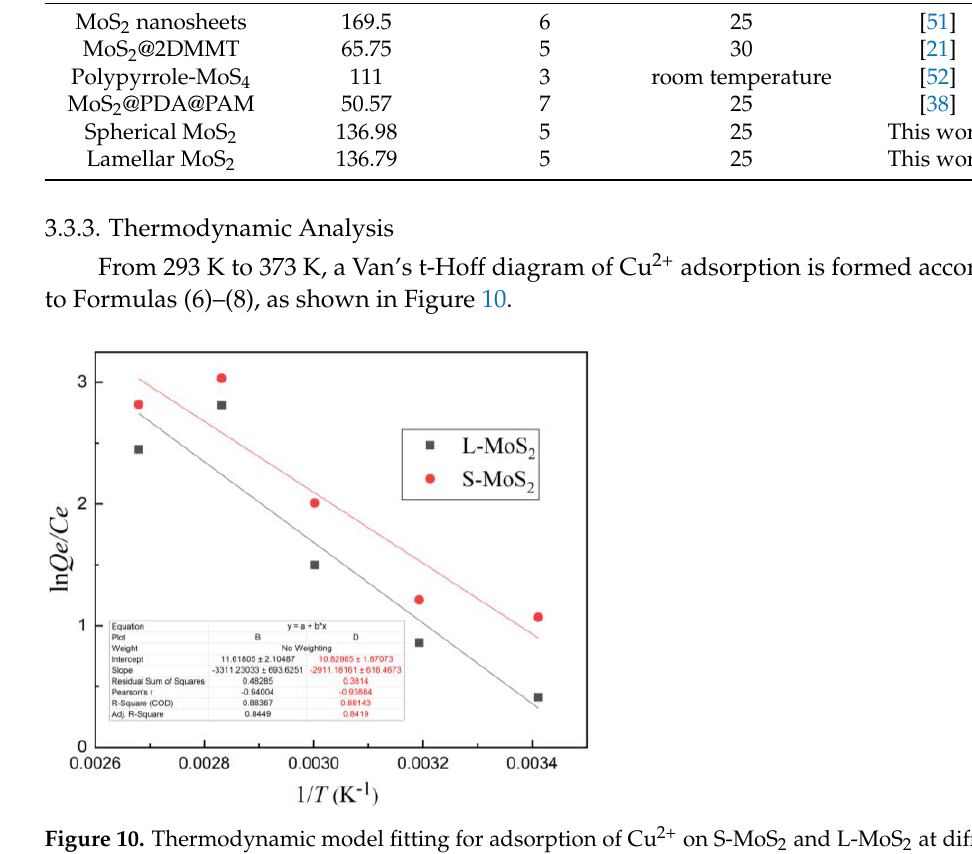
Table 2. Comparison of the maximum copper (II) ions adsorption capacities for various MoS 2 adsorbents from Langmuir isotherm. Adsorbent Q m (mg/g) MoS 2 nanosheets